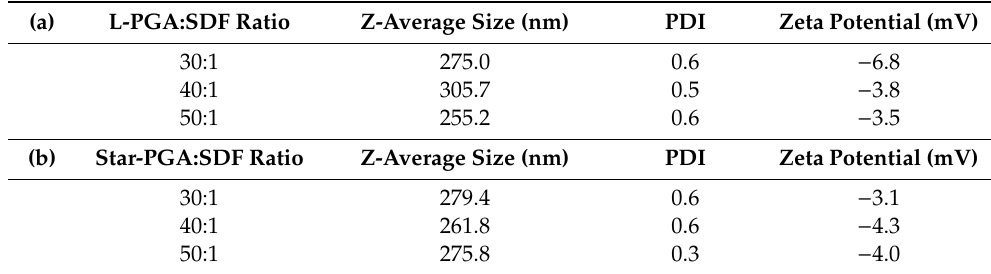
Table 1. Z-average size, polydispersity index (PDI) and zeta potential of ( a ) Linear-poly(glutamic acid) (PGA)—Stromal-Derived Factor 1 α (SDF) formulations at molar ratios of 30:1, 40:1 and 50:1 and ( b ) star-PGA–SDF formulations ( n =